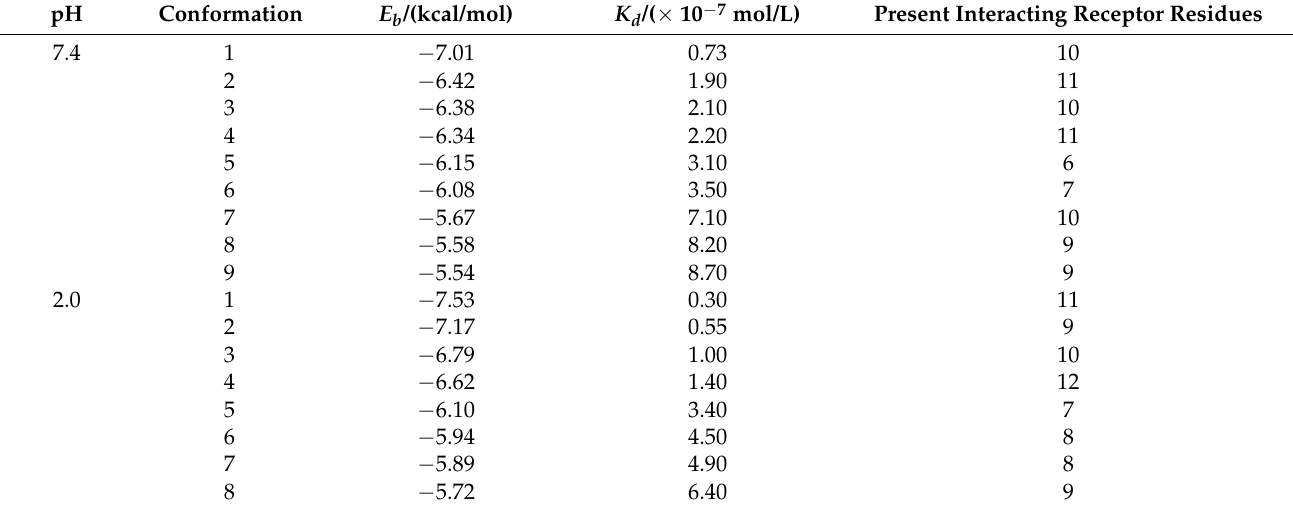
Table 2. Binding energy and dissociation conformation of all conformations obtained by docking of curcumin to β -casein. pH Conformation E b /(kcal/mol) K d /( × 10 − 7